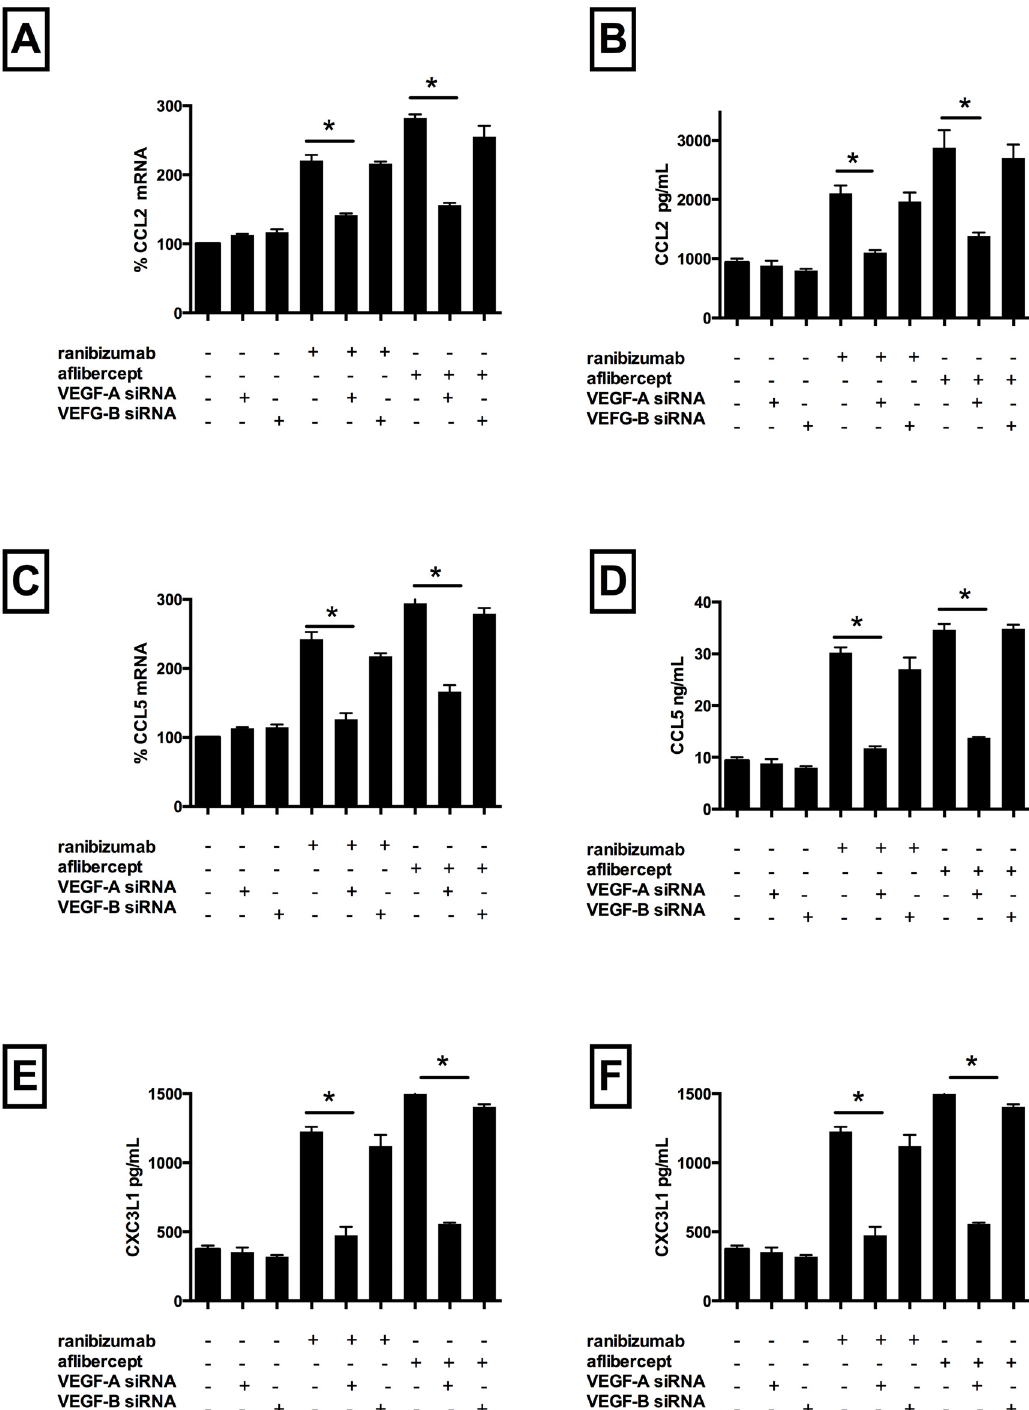
Fig 4. Inhibition of VEGF-A gene synthesis decreased ranibizumab and aflibercept mediated CCL2 CCL5, and CX3CL1 mRNA and protein levels in HCAECs. HCAECs were transfected with VEGF-A siRNA or VEGF-B siRNA. After 72h, cells were co-incubated with ranibizumab (0.1nM) or aflibercept (0.45nM), or PBS (control) for 16 h. Changes in CCL2, CCL5 and CXC3L1 (panels A, C and E) mRNA levels were quantified using real-time PCR. Protein levels (B, D, F) were quantified using ELISAs. Results are expressed as means +/- SEM. * P < 0.05 ranibizumab-treated non VEGF-A siRNA transfected cells vs. ranibizumab-treated VEGF-A siRNA transfected cells; ** P < 0.05 aflibercept-treated non VEGF-A siRNA transfected cells vs. aflibercept-treated VEGF-A siRNA transfected cells.